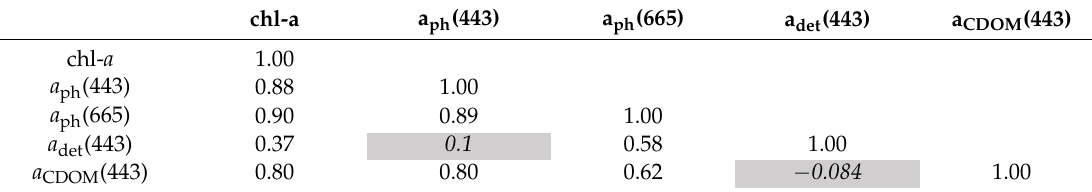
Table 3. Correlation matrix depicting the relationships amongst the water parameters (N = 62). The correlation coefficients that were not statistically significant (p < 0.05) are marked in